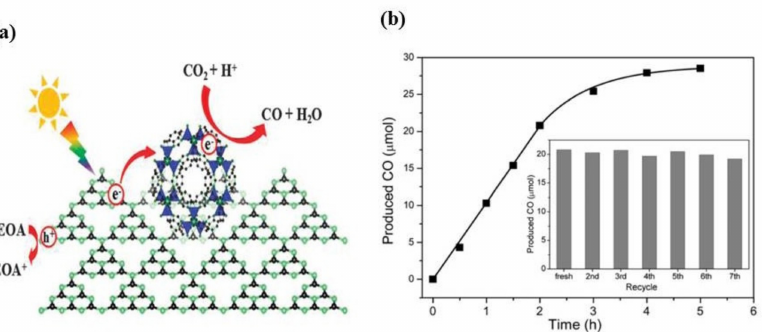
Figure 20. ( a ) Reaction pathway of the cooperation of Co-ZIF-9 and g-C 3 N 4 for CO 2 photoreduction under visible light illumination, ( b ) CO production from the Co-ZIF-9 and g-C 3 N 4 -based hybrid system as a function of the reaction time. Inset: recycling tests for CO 2 photocatalytic reduction under visible light illumination [232].